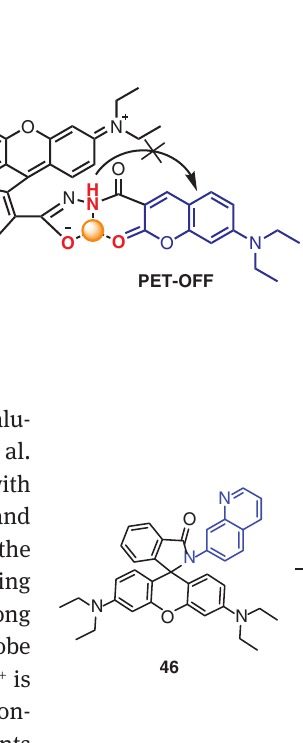
Figure 28: (A) Recognition mechanism of probes 41–44 with Fe 3 + and (B) fluorescent images of HeLa cells incubated with 20 μ m probes 42–44 for 30 min. Reprinted from Yang et al. (2012).